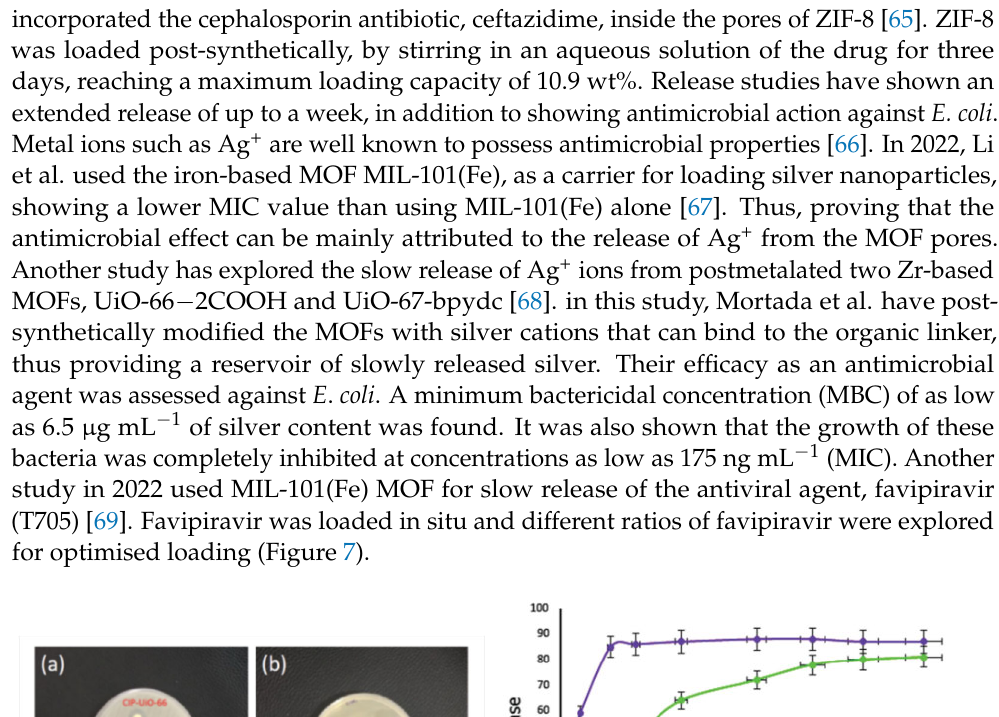
Figure 6. ( Left ): Disk diffusion studies on ( a ) S. aureus and ( b ) E. coli. ( Right ): pH ‐ stimulated release of CIP from UiO ‐ 66. Reproduced with permission from [60] .